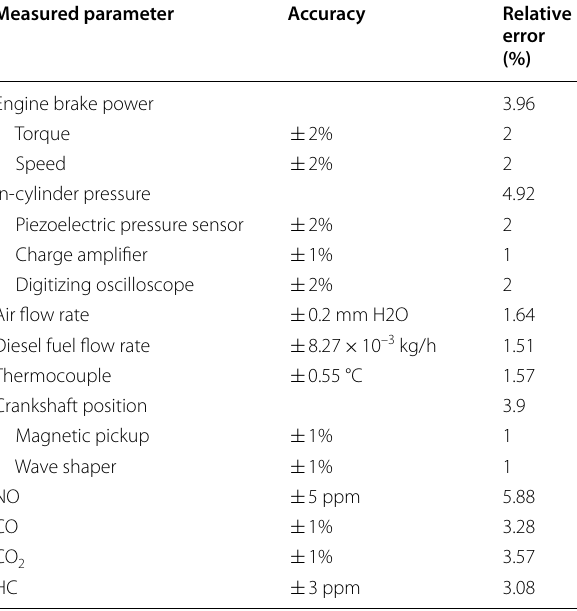
Table 5 Accuracy and relative error of measured parameters Measured